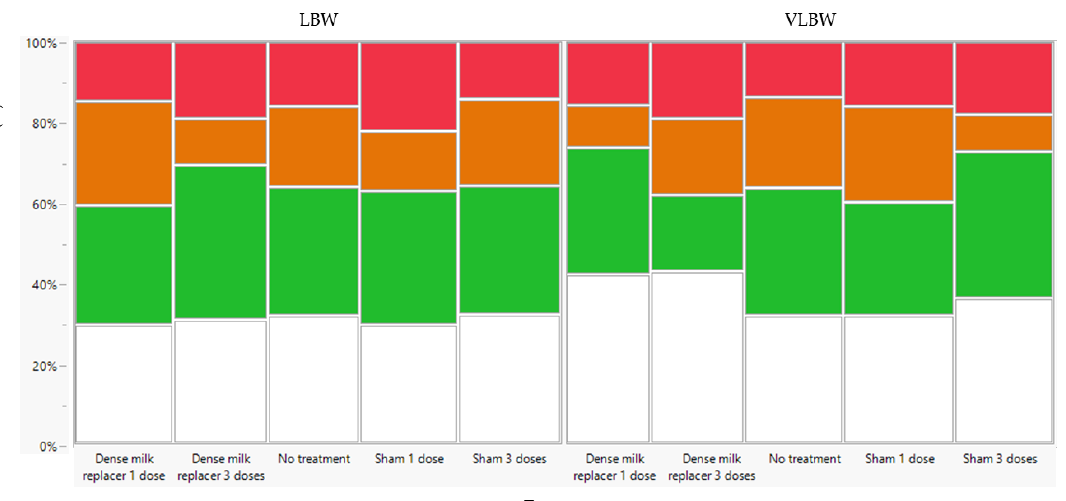
Figure 3. Distribution of skin lesion (SL) scores at Farm A (low perinatal management) of the se- lected low birth weight (LBW, n = 80) and very low birth weight (VLBW, n = 80) piglets per treatment (dense milk replacer [DMR] one dose, DMR three doses, no treatment, sham one dose, sham three doses). There was a no significant effect of treatment or birth weight category on the probability of having more severe SL. The following scoring system was applied: 0: no lesions (white); 1: < 5 su- perficial lesions (skin unbroken) (green); 2: 5-10 superficial lesions or < 5 deep lesions (skin broken and evidence of haemorrhage) (orange); 3: > 10 superficial lesions or > 5 deep lesions (red).